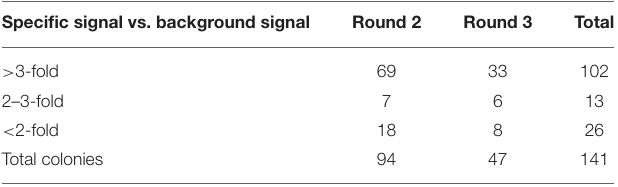
TABLE 1 | PE-ELISA of individual antigen-binding Clec4F nanobodies from panning of round 2 and 3. Specific signal vs. background